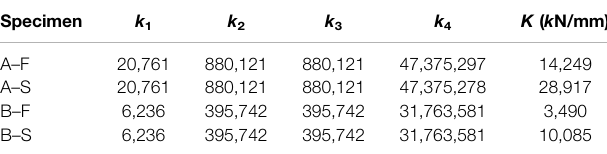
TABLE 2 | Load value of free end of U type steel damper.